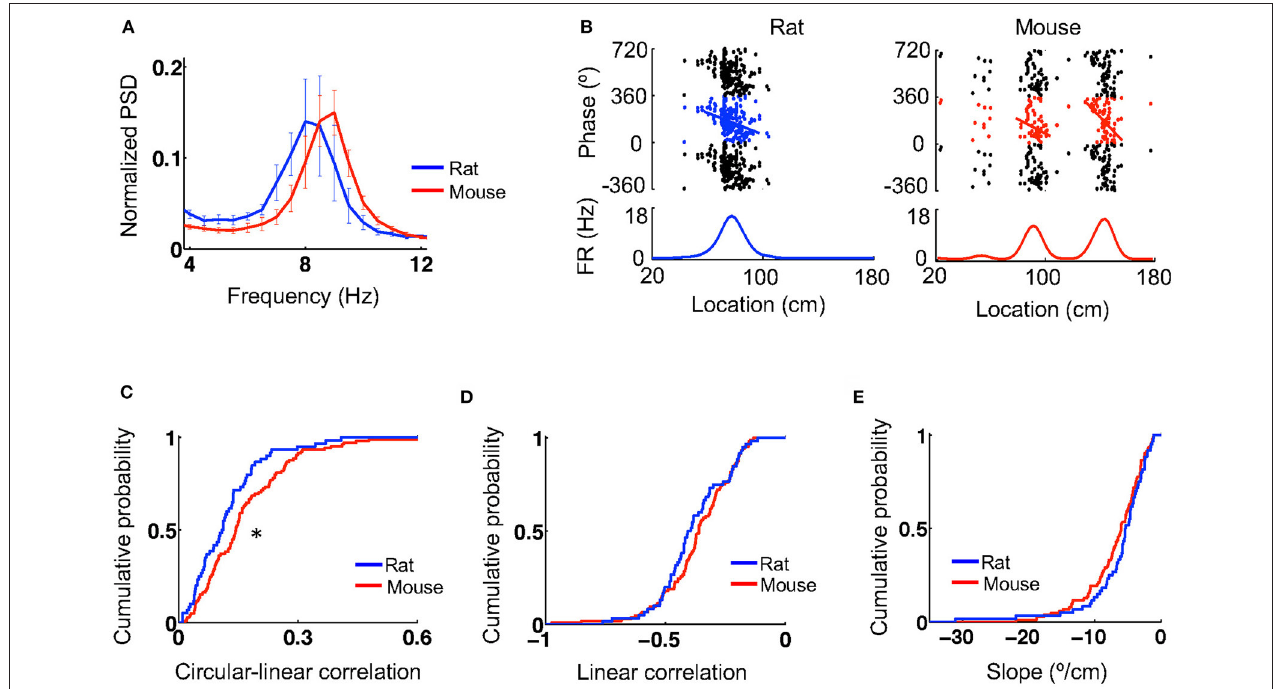
FIGURE 3 | Theta oscillations and theta phase precession were similar between mice and rats. (A) Average (mean and s.e.) power spectral densities (PSDs) of mouse and rat CA1 LFPs. The PSDs were normalized by the total power within [2,400] Hz. (B) Theta phase precession of the same example cells in Figure 1A . In each panel, the top shows spike phases plotted against their locations on the track. The same spikes were plotted for 3 cycles of circular phases. Line: optimal linear regression between spike phases and locations. The bottom shows the firing rate curve of the cell. (C–E) Cumulative distributions of circulation-linear correlation (C) , optimal linear correlation (D) , and associated slope (E) between spike phases and spike locations for rat and mouse place cells on the novel track. * P <